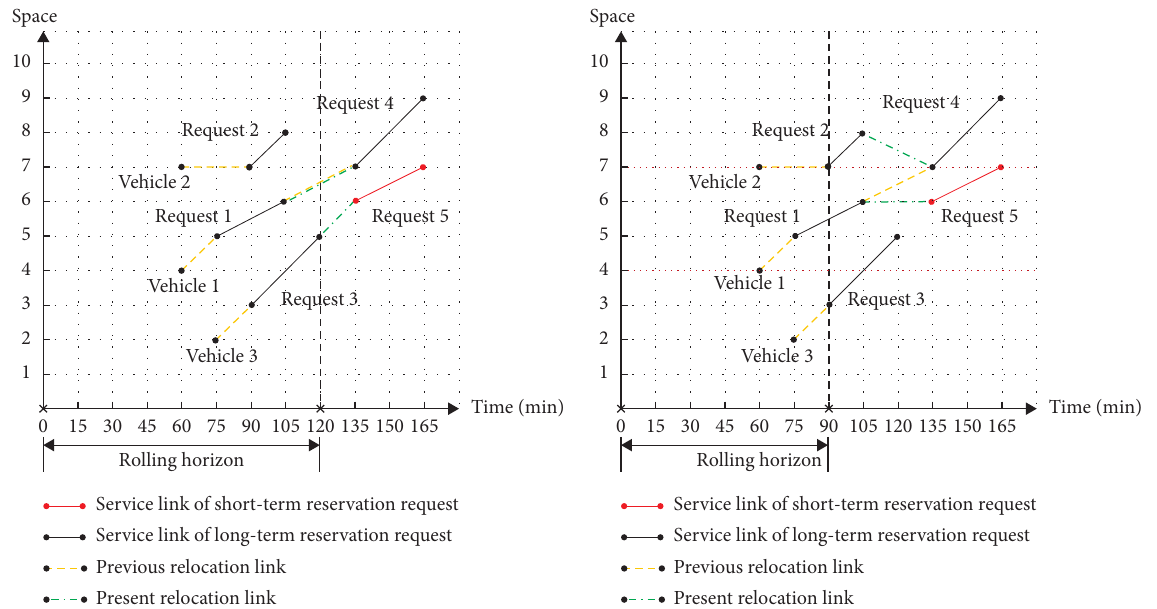
Figure 4: Comparison of different rolling horizon scheduling results.